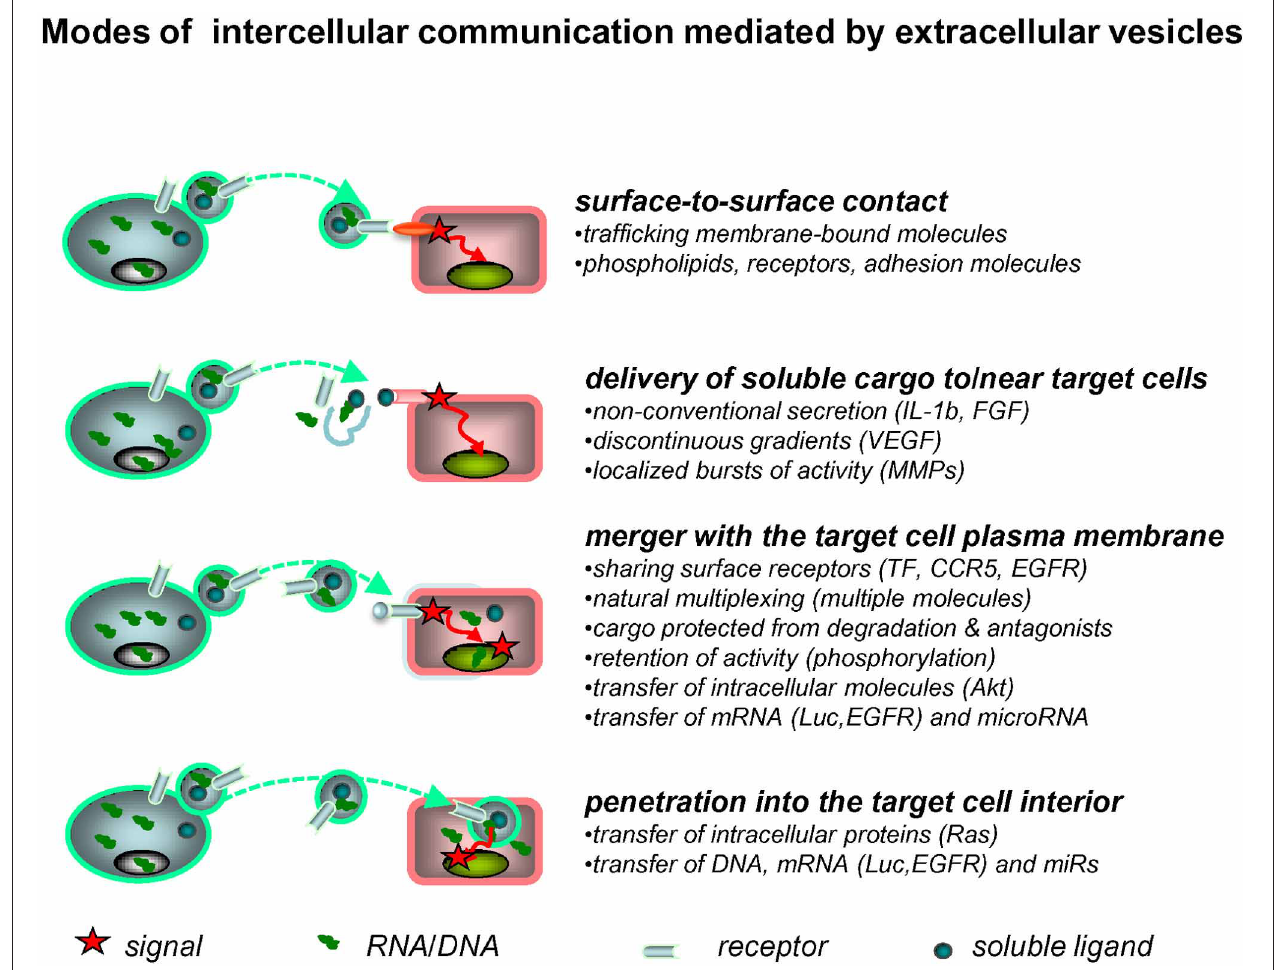
FIGURE 1 | Extracellular vesicles as mediators of intercellular communication. Exchange of molecular information between cells may be mediated by EVs in several ways. Thus, surface receptors of EVs may interact directly with counter-receptors on the surface of a target cell. The latter may also come into contact with the bioactive